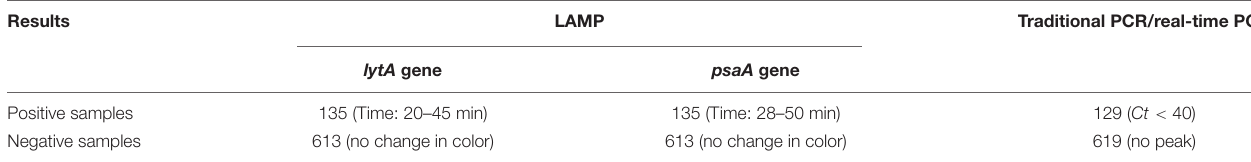
TABLE 2 | Comparison between loop-mediated isothermal amplification assay and polymerase chain reaction for Streptococcus pneumoniae detection from clinical samples.